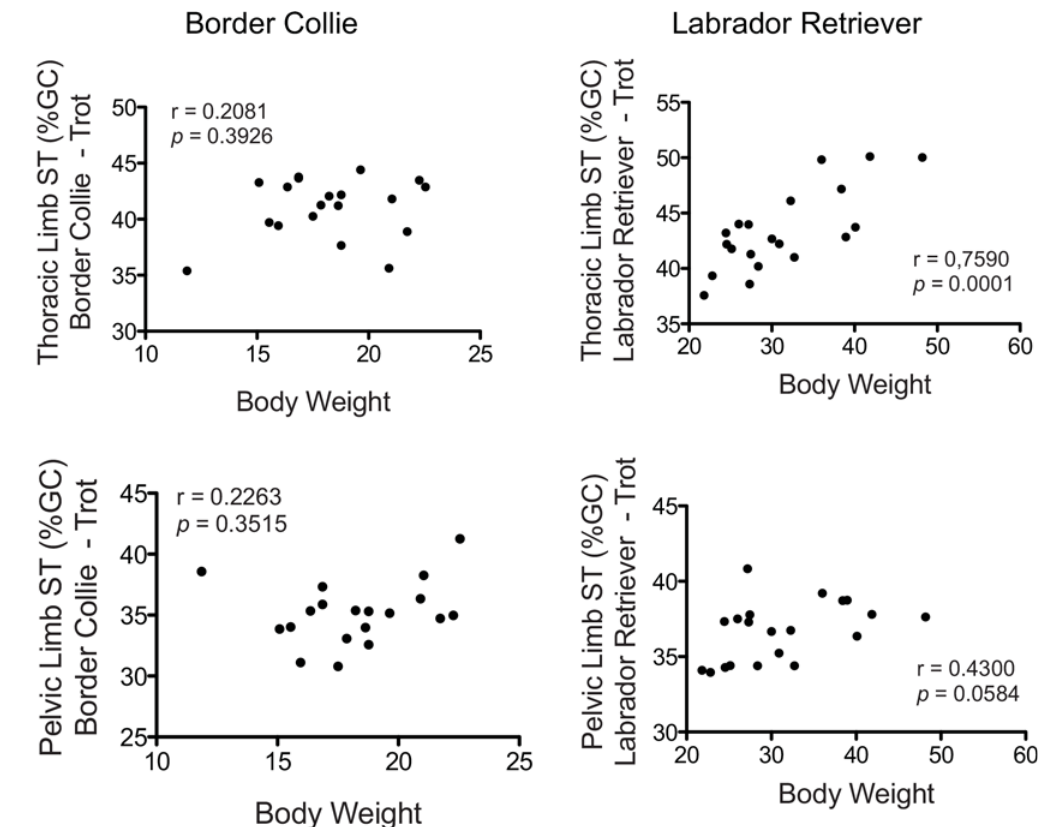
Fig 5. Thoracic and Pelvic Limb Stance Time as a Percentage of Gait Cycle (ST%) compared to Body Weight in Border Collies and Labrador Retrievers. There was no relationship between body weight and stance time of the thoracic or pelvic limbs in the trotting Border Collies. In the trotting Labrador Retrievers, there was a significant positive relationship between body weight and thoracic limb stance time and a strong trend towards a significant relationship between body weight and pelvic limb stance time.